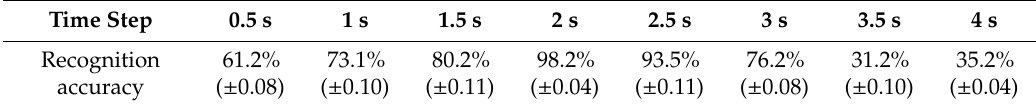
Table 2. The e ff ect of sliding window size on classification.